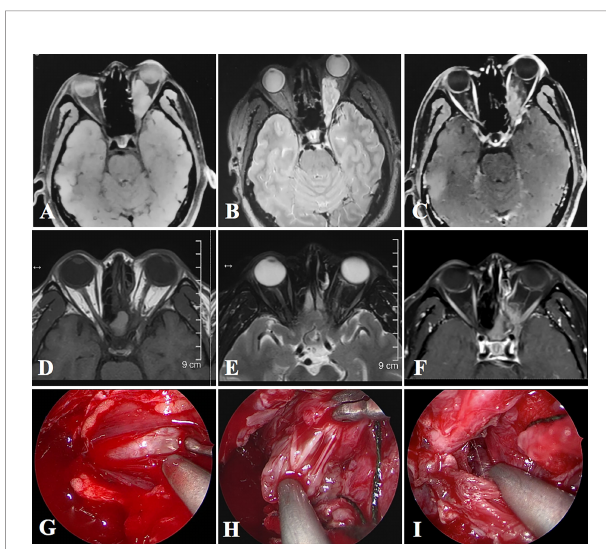
FIGURE 3 | Images of Case 2. (A – C) Preoperative MRI shows an intraconal lesion in the left orbit, with both medial and lateral extension. (D – F) Six-month follow-up MRI shows no recurrence of the tumor. (G) Exposure of the intraconal tumor. (H) The carrier nerve of the tumor. (I) Inspection after total resection of the